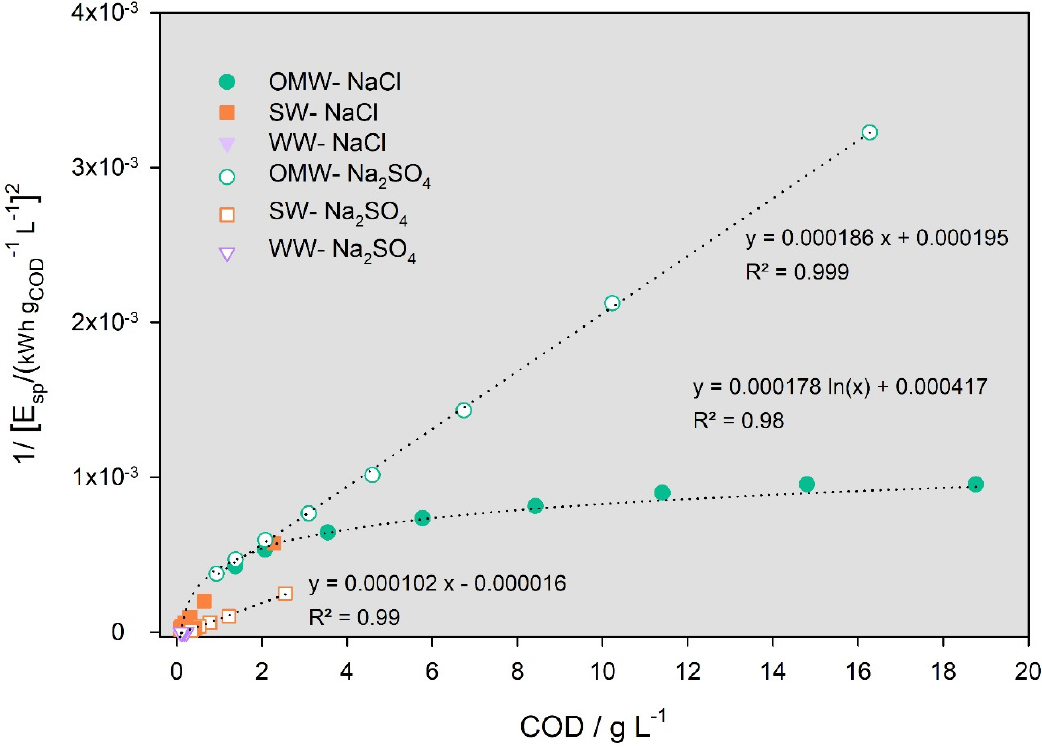
Figure 5. Variation of 1/(E sp ) 2 with COD for the degradation assays performed with different electrolytes and wastewaters: dots—experimental results; lines—adjusted equations. OMW—Olive mill wastewater, SW—Slaughterhouse wastewater, WW—Winery wastewater.